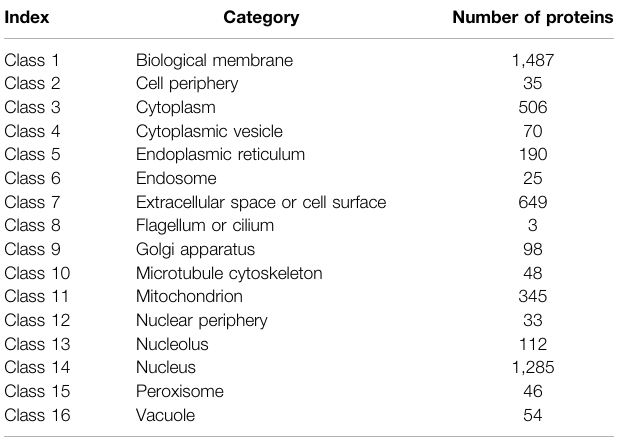
TABLE 1 | Number of proteins in each